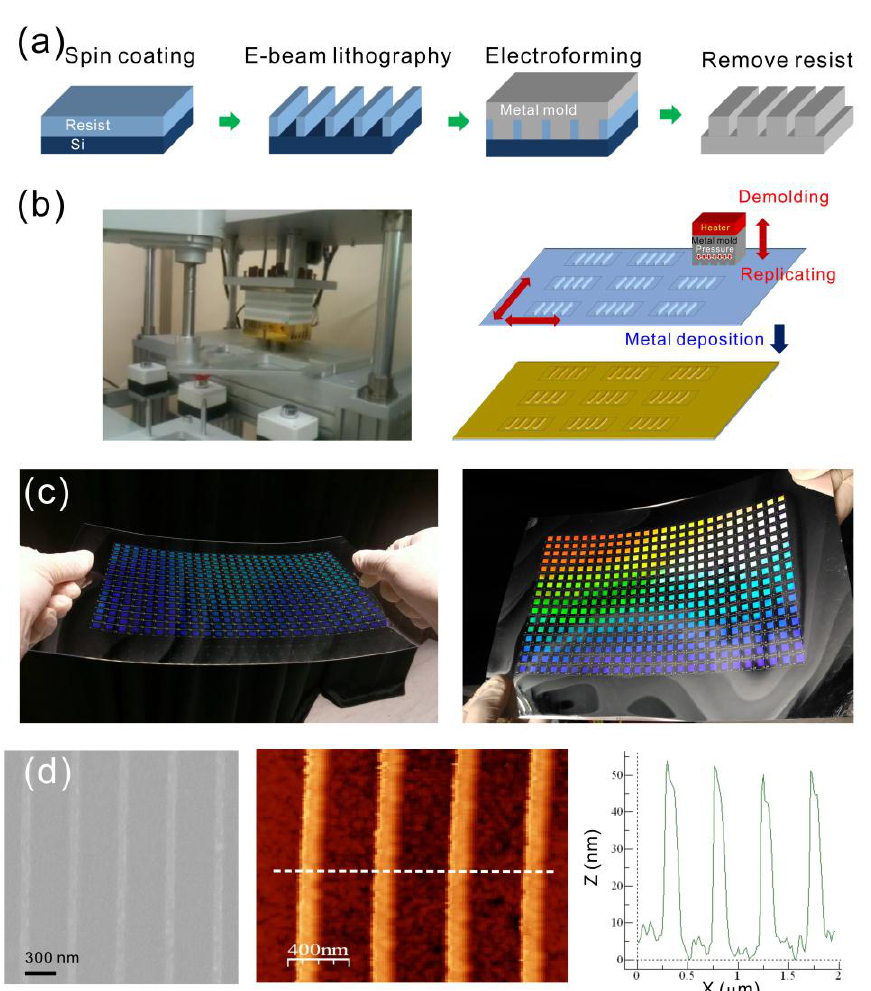
Figure 1. ( a ) The fabrication process for Ni–Co mold; ( b ) the homemade hot-embossing machine for rapidly generating arrays of nanostructures on an A4 size plastic film; ( c ) the optical image of the replicated nanostructure (left) and capped aluminum nanoslit arrays (right) on an A4 size polycarbonate film. There are 416 arrays and the area of each periodic nanostructure is 5 × 5 mm 2 ; ( d ) the SEM (left), AFM (middle), and cross-sectional profile (right) of the capped aluminum nanoslits.